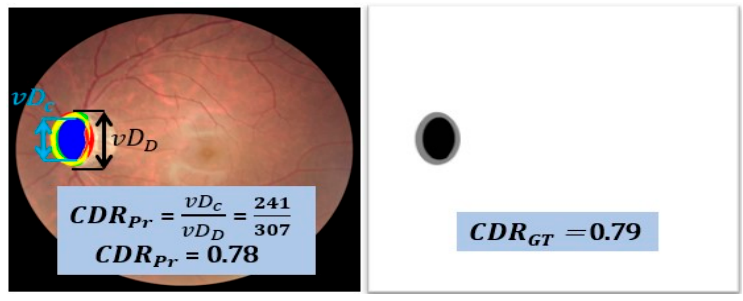
Figure 12. Sample CDR computation using the REFUGE dataset.